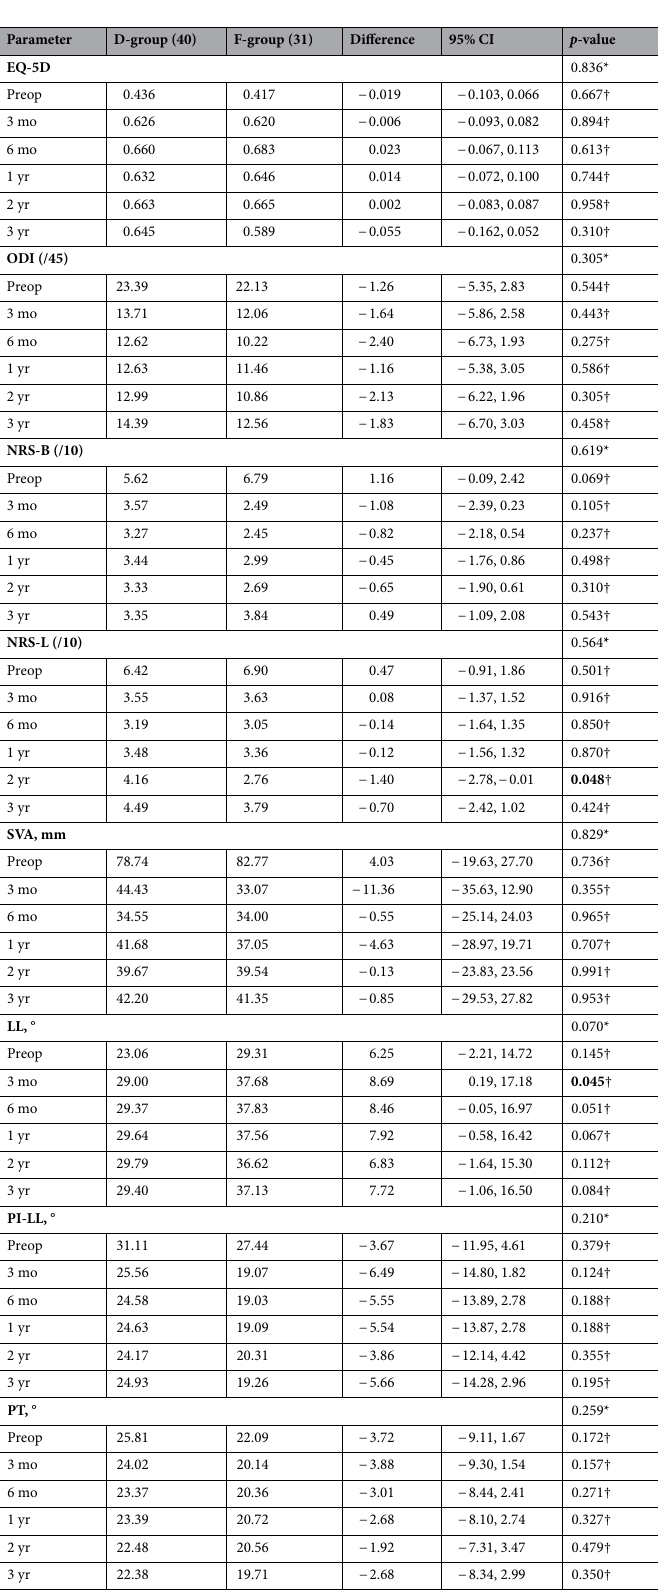
Table 2. The adjusted least squares means of clinical and radiological parameters. EQ-5D euro-quality of life-5 dimensions, ODI oswestry disability index, NRS-B numerical rating score of pain on back, NRS-L numerical rating score of pain on leg, SVA sagittal vertical axis, LL lumbar lordosis, PI-LL difference between pelvic incidence and lumbar lordosis, PT pelvic tilt, CI confidence interval, Preop preoperative. *comparison between groups with time. † post hoc analysis. Boldface type indicates statistical